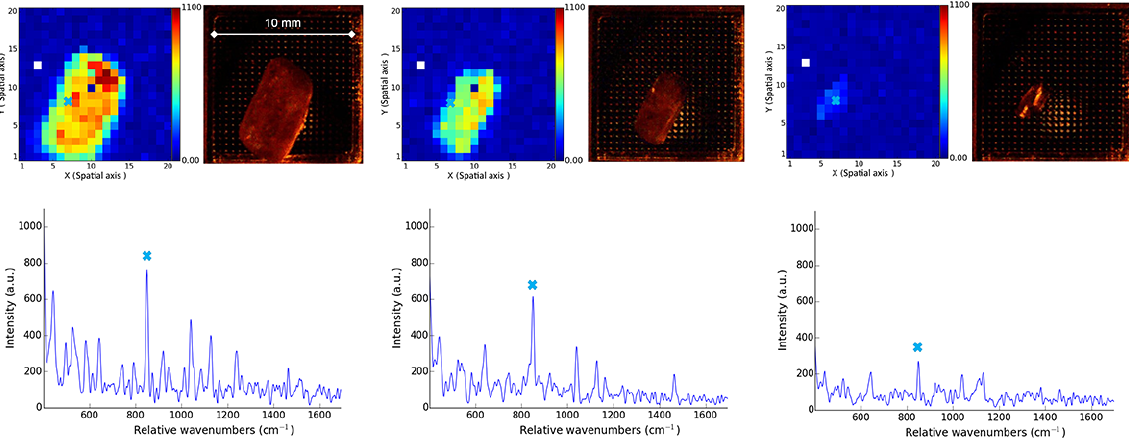
Figure 14. Piece of sugar in water. The dissolving process is tracked using quasi real-time Raman imaging: first frame (left, 0s), 20th frame (center, 390s), and 40th frame (right, 780s). The pseudo colors illustrate the intensity at 850cm − 1 . Below the corresponding Raman spectra at the spatial position ( X/Y ) = (7 / 8) are